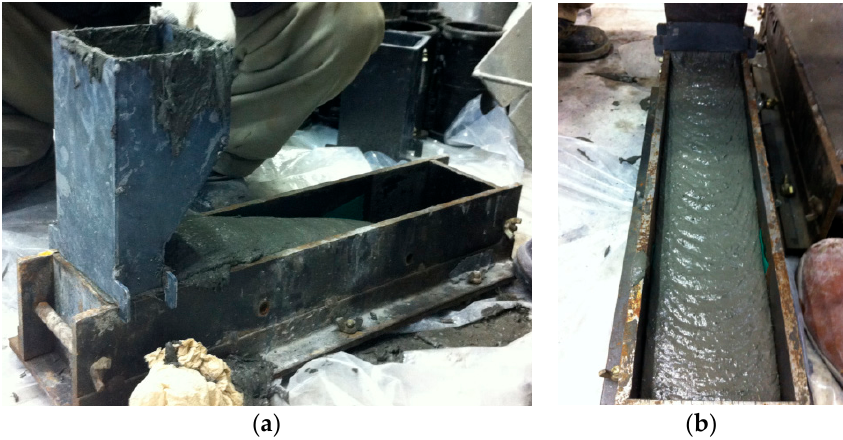
Figure 2. Placing method adopted for fabricating beam specimen. ( A ) Device; ( B ) Material flow.